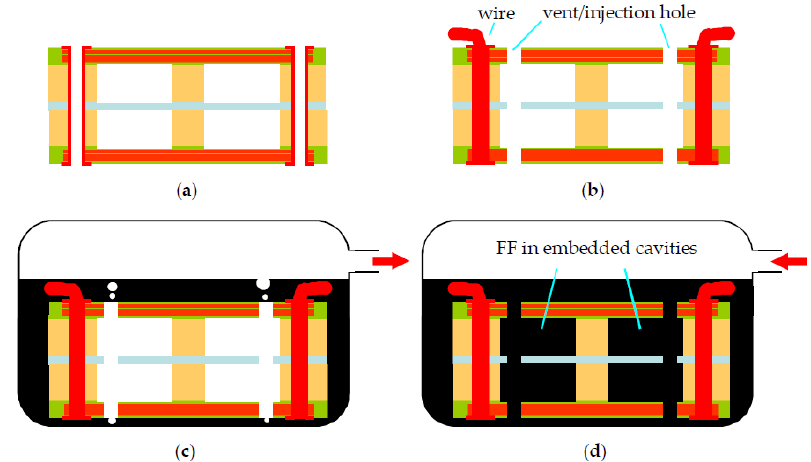
Figure 5. AA’ cross section in Figure 1 showing the FF injection processes. ( a ) Device after standard PCB manufacturing processes; ( b ) Vent/injection hole drilling and wire connection; ( c ) Cavity evacuation; ( d ) FF injection.